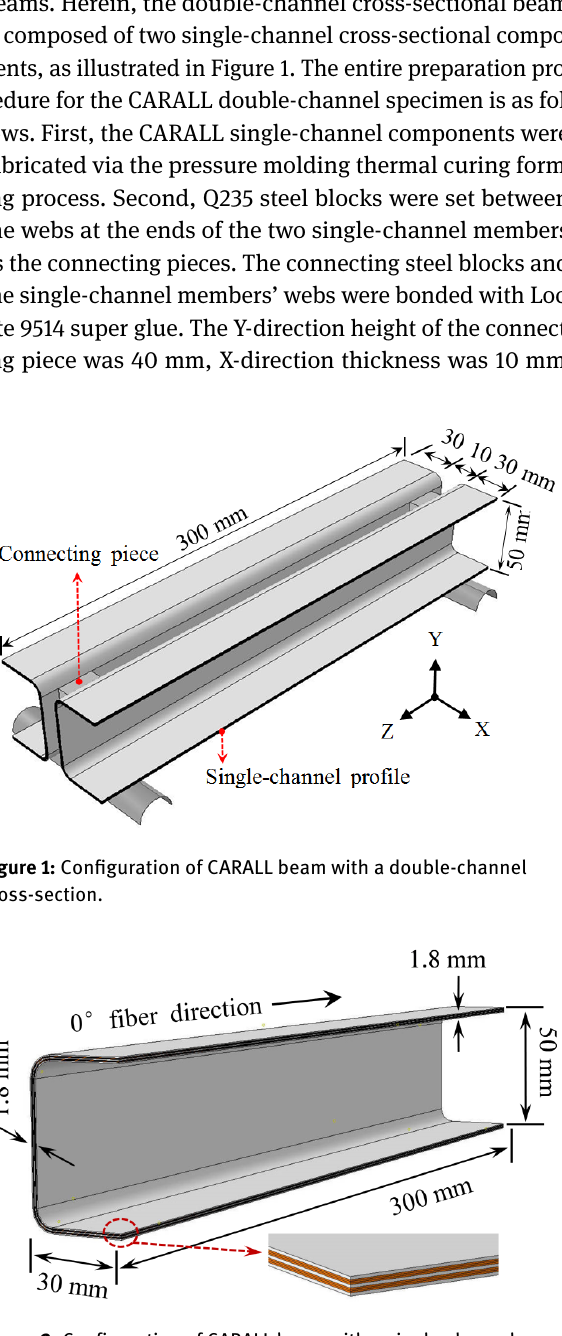
Figure 2: Configuration of CARALL beam with a single-channel cross-